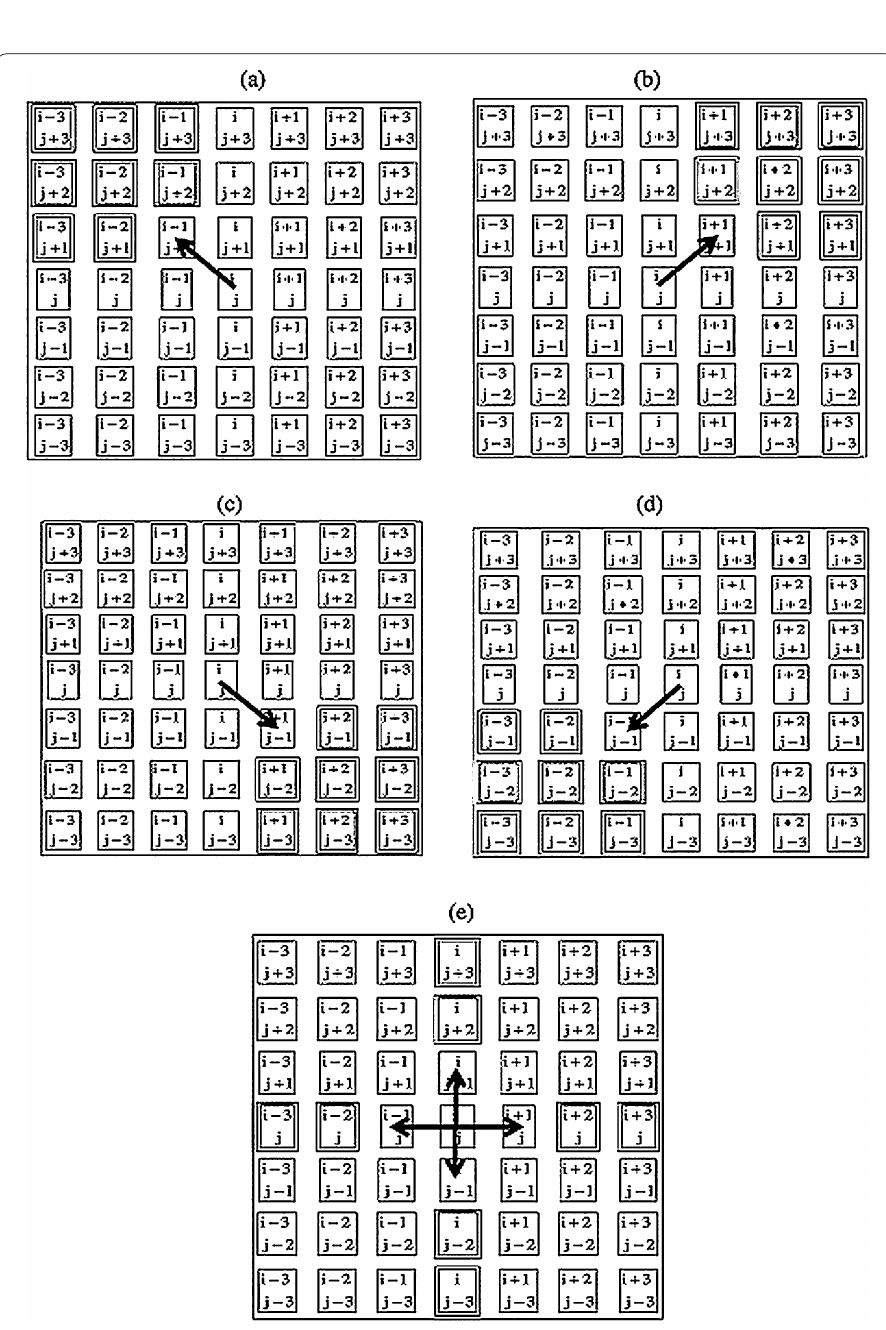
Figure 2 Diagram showing how a receptor at the location ( i , j ) moves towards a bound receptor in its neighborhood. Here, a double box denotes a bound receptor. In (a) , the receptor will move to the location ( i – 1, j + 1) if a bound receptor is found at one of the locations shown surrounded by double boxes on the upper left hand corner. In (b) , the receptor will move to the location ( i +1, j +1) if a bound receptor is found at one of the locations shown surrounded by double boxes in the upper right hand corner. In (c) , the receptor will move to ( i + 1, j – 1) if a bound receptor (doubly boxed) is found in the lower right hand corner. In (d) , it moves to ( i – 1, j – 1) if a bound receptor (doubly boxed) is found in the lower left hand corner. Finally, in (e) the receptor will move either vertically or horizontally if a bound receptor is found vertically above (or below) it, or to its left (or right),